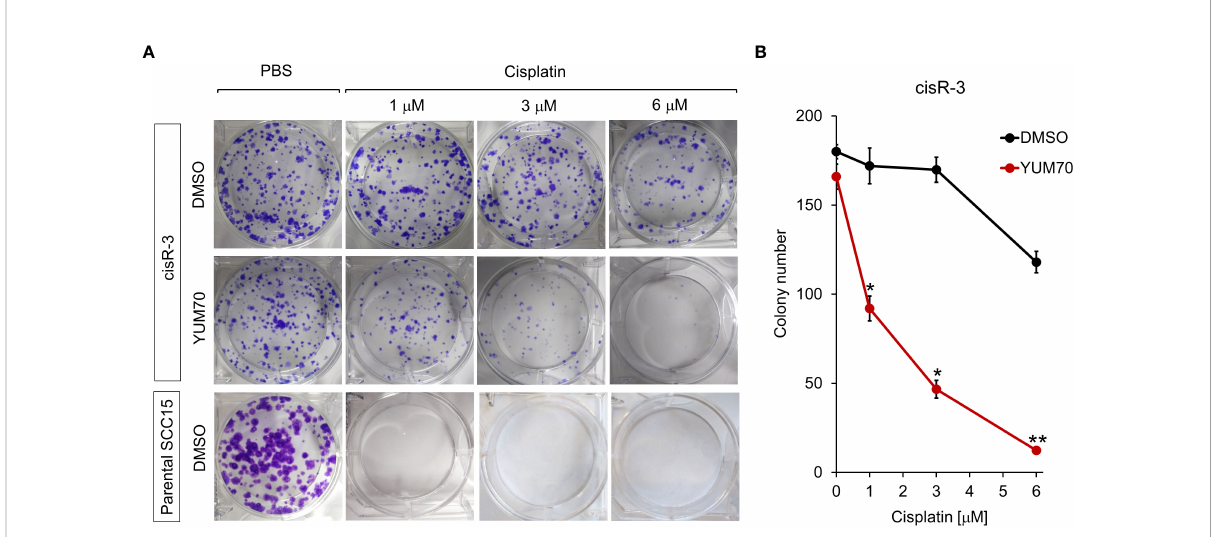
FIGURE 7 YUM70 in combination with cisplatin reduces clonogenic capacity of cisplatin-resistant SCC15 cells. (A) CisR-3 cells or parental SCC15 cells were treated with the indicated dosages of cisplatin alone or in combination with 2.5 m M of YUM70, with DMSO serving as vehicle control, for 48 hr. Colonies formed after 12 days post-treatment were stained with crystal violet and counted. (B) Quantitative results of (A) . Data are presented as means ± S.D. (n=3). * P ≤ 0.05, ** P ≤ 0.01 (Student ’ s t